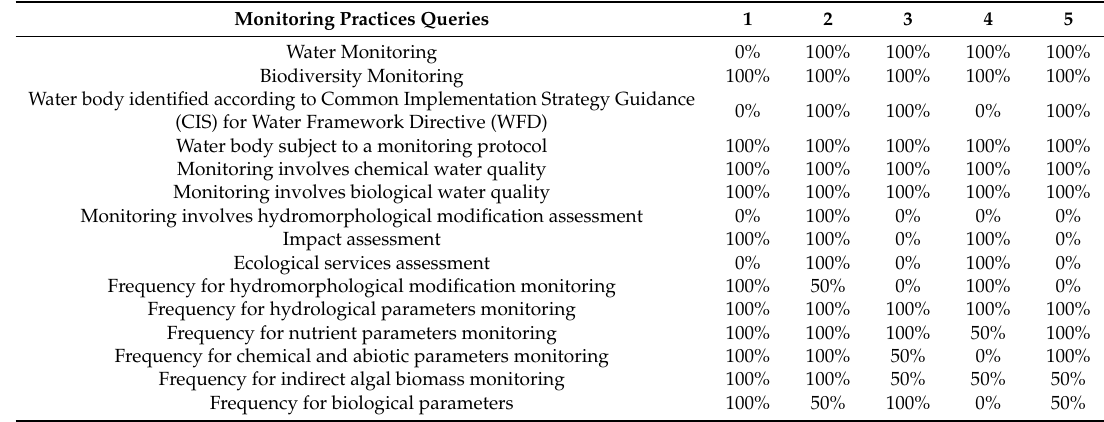
Table 2. Percentages of gap analysis of the five PAs regarding the monitoring practices. 1: L’ Albufera, 2: Krka, 3: Mincio, 4: Una, 5: